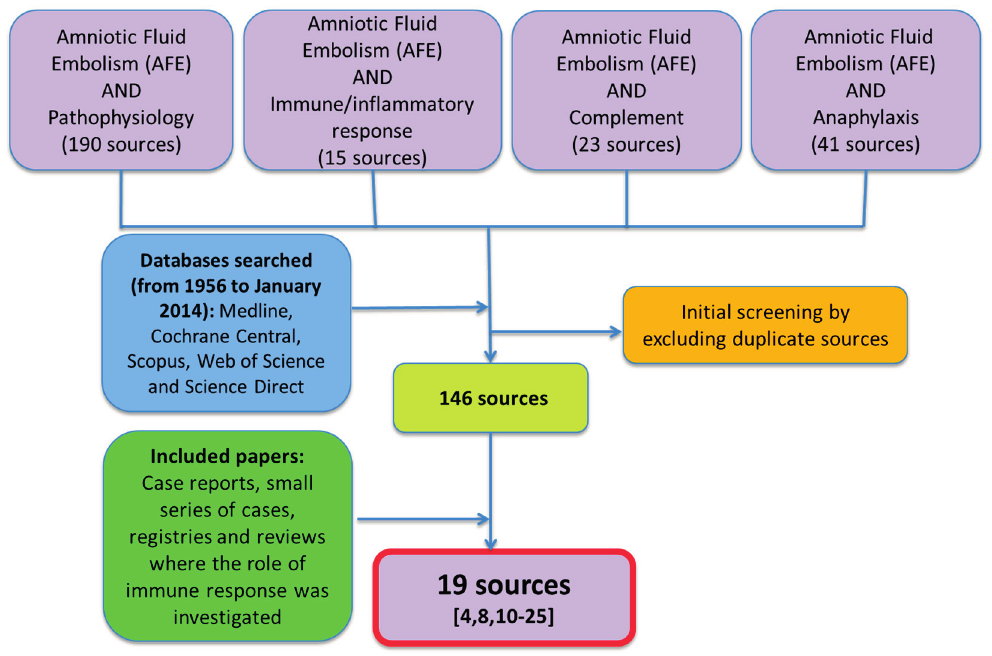
Figure 1. Flow-chart of the papers selected for the purposes of the